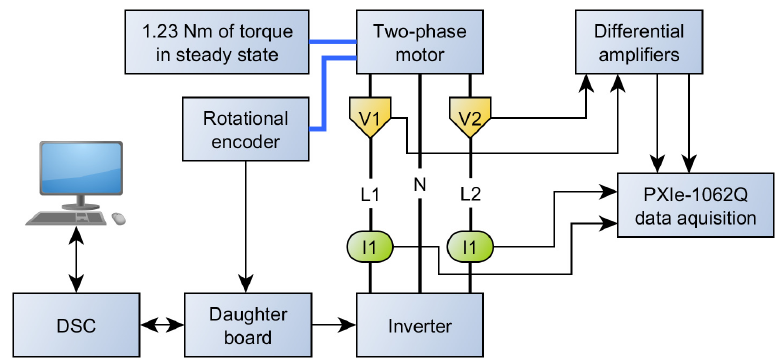
Figure A1. Schematic of experimental setup.